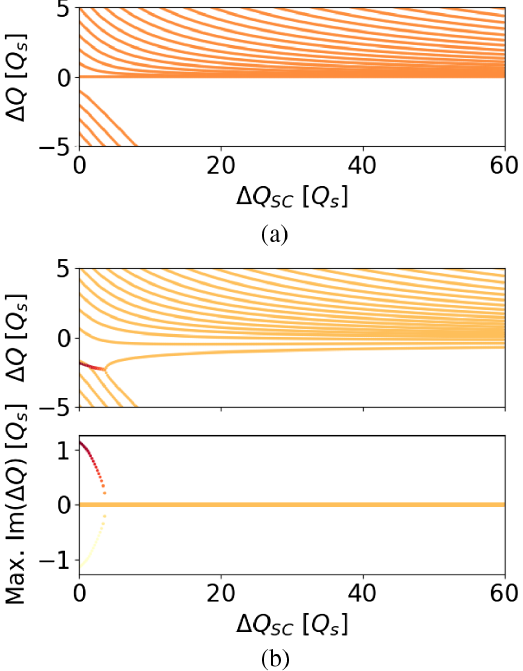
FIG. 3. Evolution of the complex tune shifts of the coherent modes as a function of the normalized space charge tune shift for an airbag distribution, without wakefields (above) and with wakefields featuring fixed wakefield strength corresponding to a normalized intensity of 20 (below). In the absence of wake- fields, all tunes are purely real. Otherwise, to ease the identi- fication of the modes in the plots of the real and imaginary tune shifts, the dots are color coded identically according to the imaginary part. (a) Without wake elds (b) With